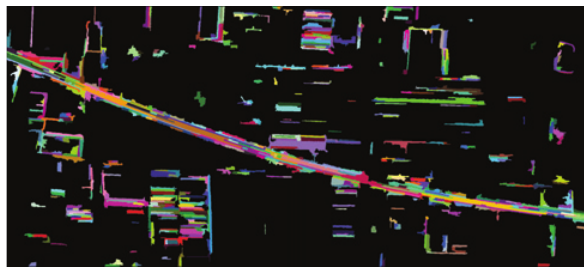
Figure 7. Segments in